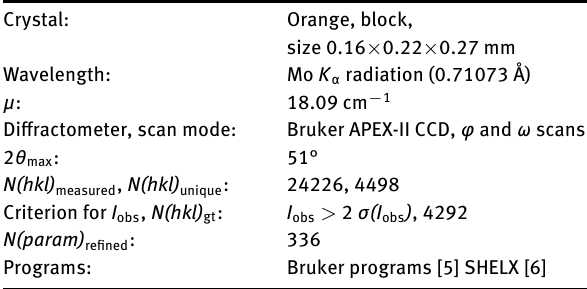
Table 1: Data collection and